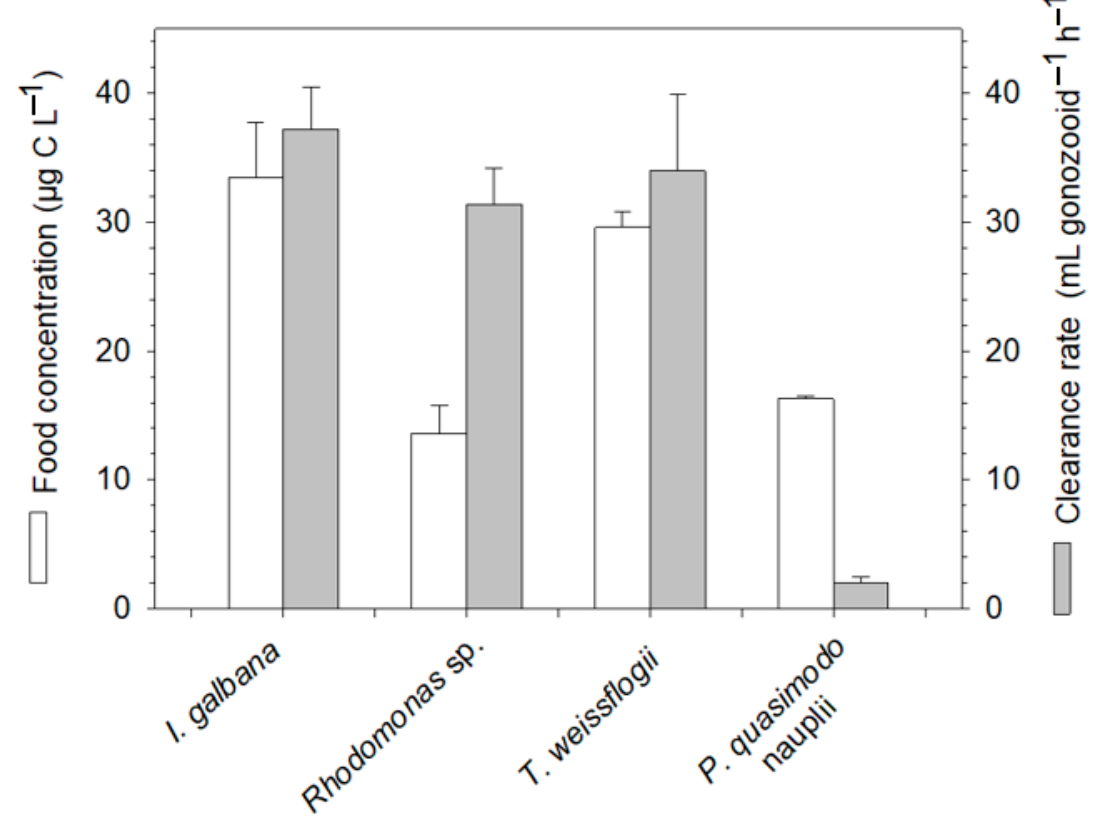
Figure 3. Zooids (phorozooids and gonozooids) of Dolioletta gegenbauri (6–6.5 mm body length) feeding simultaneously on three species of phytoplankton and nauplii of Paracalanus quasimodo. Arithmetic means and standard errors are given ( n = 6).